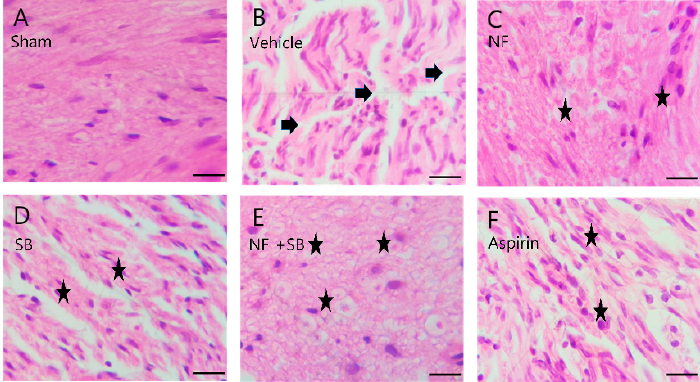
Figure 6. Representative H&E staining of sciatic nerves on 14th day after surgery. ( A ) Sham group shows well-organized sciatic nerve fibers and no structure defects. ( B ) Vehicle group shows several areas of edema and degraded myelin sheath (arrows). ( C ) NF group, ( D ) SB group, ( E ) NF + SB group, ( F ) aspirin group, ( C – F ) The nerve fiber density was increased and the vacuolar-like degeneration was decreased at the 14th day (asterisks). Scale bars = 10 µm.